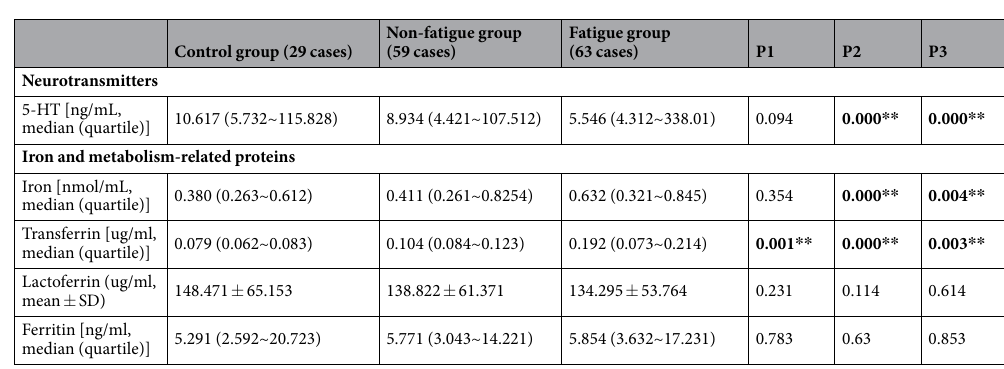
Table 2. The levels of 5-HT, iron and metabolism-related proteins in CSF among control, non-fatigue and fatigue groups. 5-HT = serotonin; P1: non-fatigue group vs. control group; P2: fatigue group vs. control group, P3: non-fatigue group vs. fatigue group. ** P <